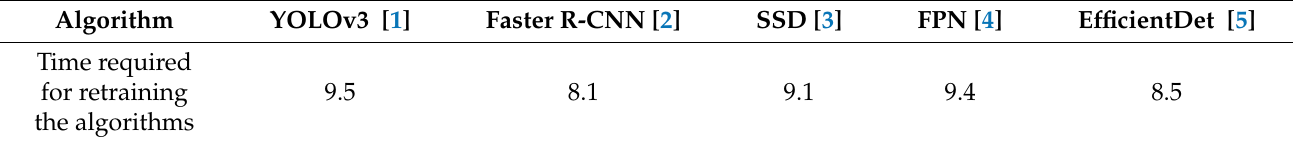
Table 1. Time required for retraining the algorithms